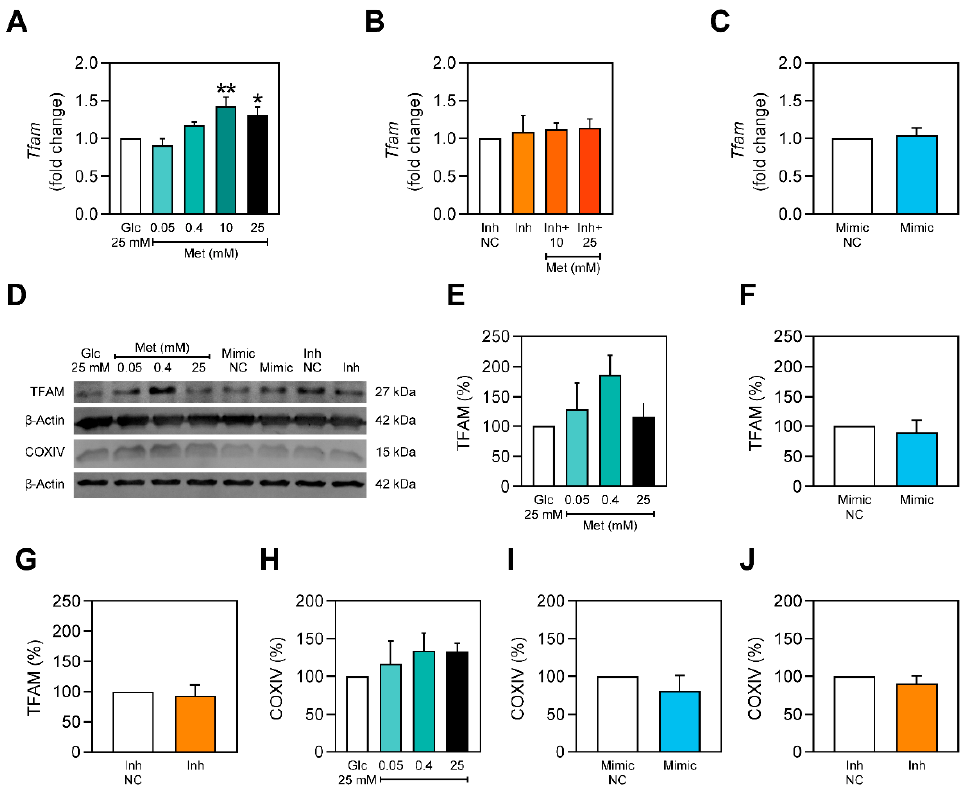
Figure 6. Metformin upregulates Tfam in C2C12 myoblasts but not when miR-378a-3p is inhibited. ( A – C ) Expression level of Tfam in C2C12 myoblasts. ( D ) Representative images of Western Blot showing TFAM and COXIV protein content. Mitochondria-related factors, such as ( E – G ) TFAM and ( H – J ) COXIV, were evaluated through Western Blot. All data is given as mean ± S.E.M. ( n = 3). * p = 0.014 versus Glc 25 mM, ** p = 0.002 versus Glc 25 mM.